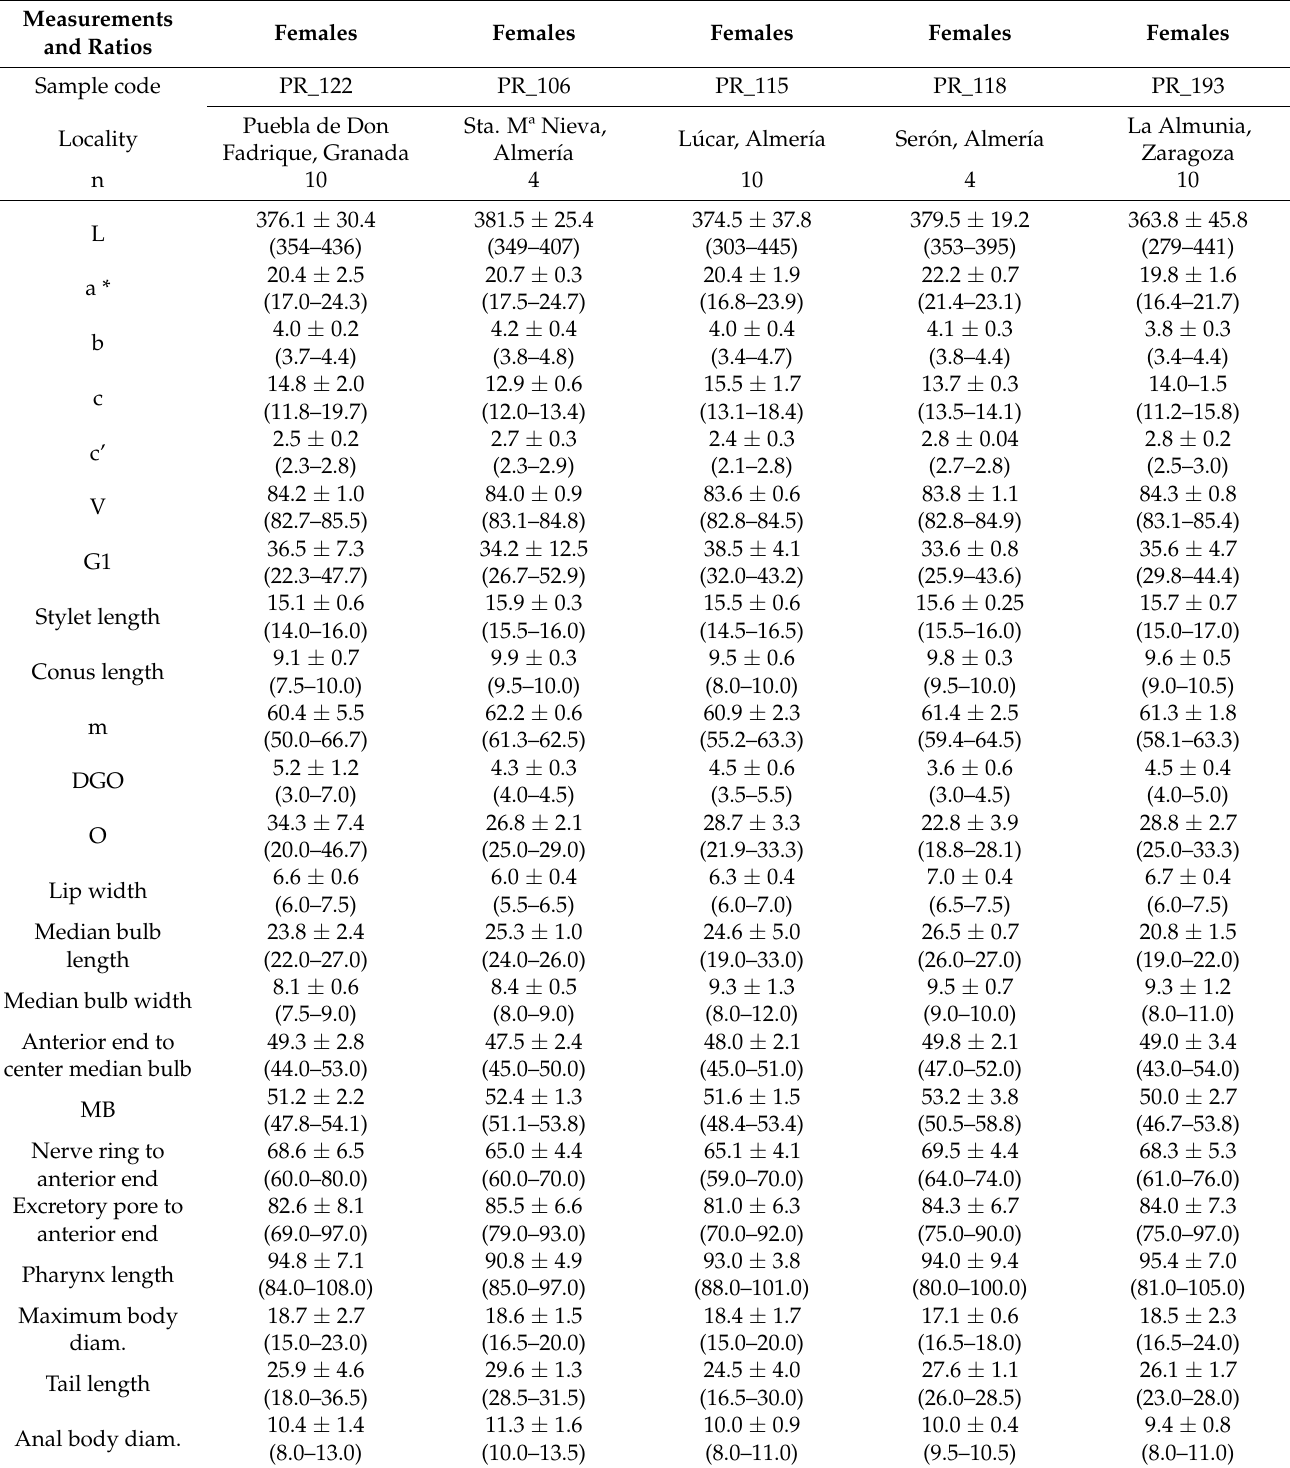
Table 9. Morphometrics of Paratylenchus veruculatus Wu, 1962 from several localities in Spain. All measurements are in µ m and in the form: mean ± s.d.